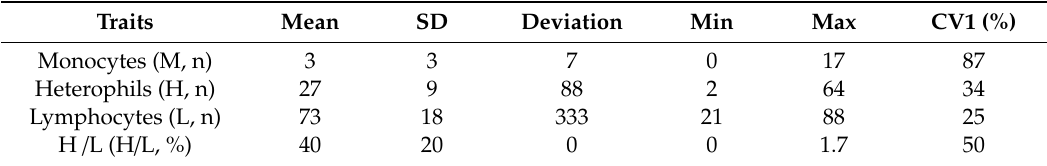
Table 1. Descriptive statistics of phenotypic data.